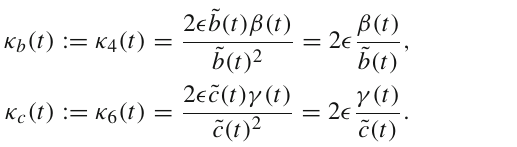
corresponds to the perturbed solution ((cid:3) = 0 . 01 ). The blue area defines the points for which the distance from the expected value is smaller √ than var (ξ 2 ; (cid:12) n ) defined by (55) (the distance is counted along fixed t